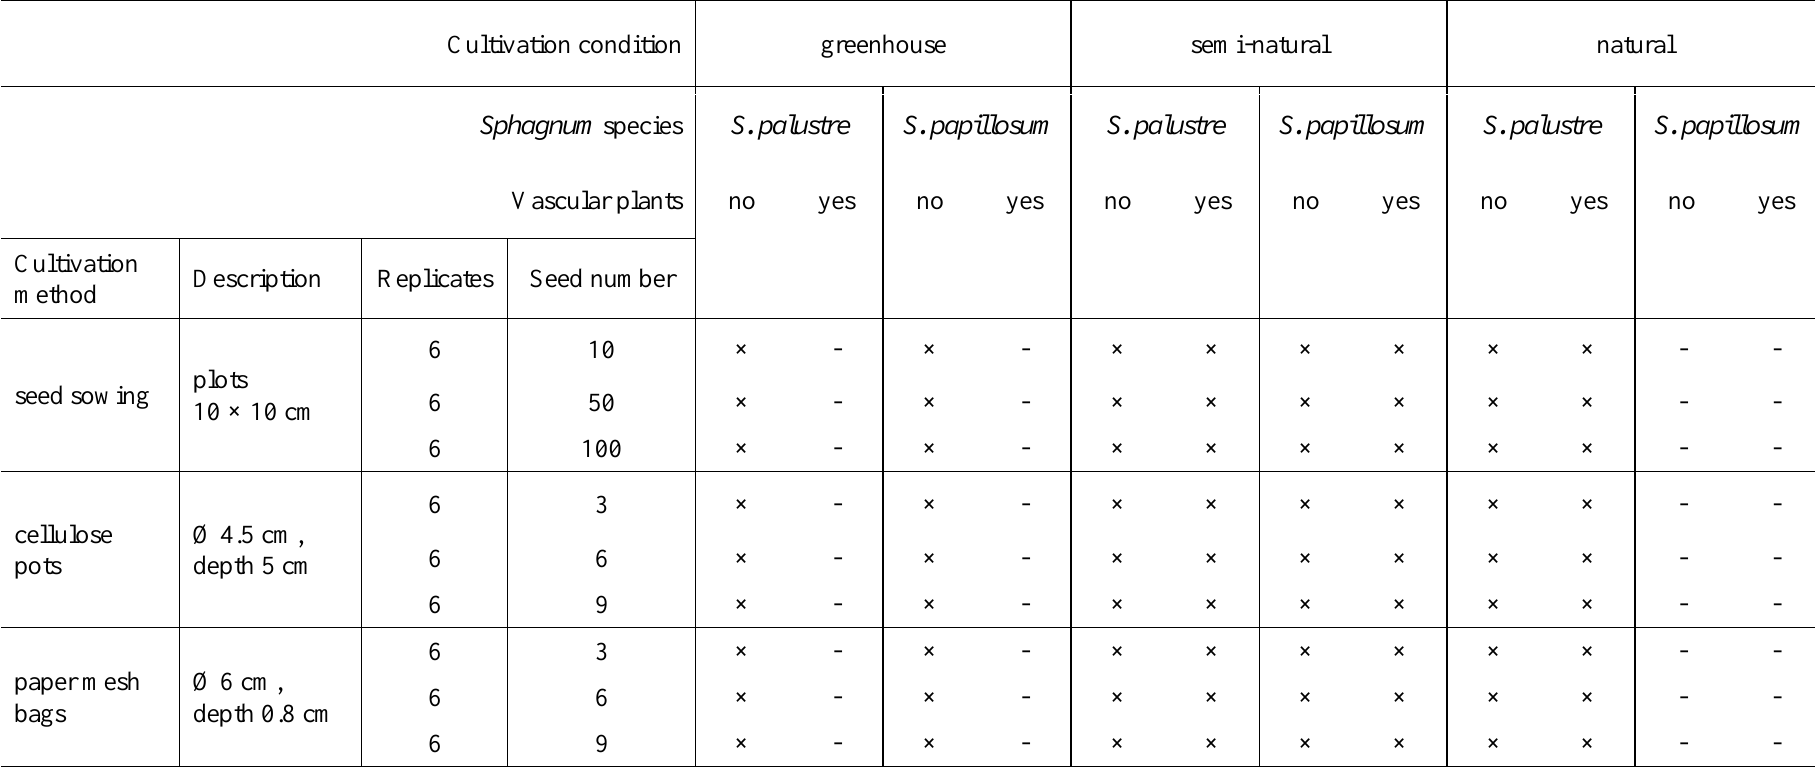
Table 1. Structure of the experiment. × performed treatment combinations, - not performed; vascular plants no = removed, vascular plants yes = not removed. In the greenhouse conditions containers were used (35.5 × 22 × 5 cm) and in semi-natural and natural conditions, permanent quadrats (1.7 × 1.7